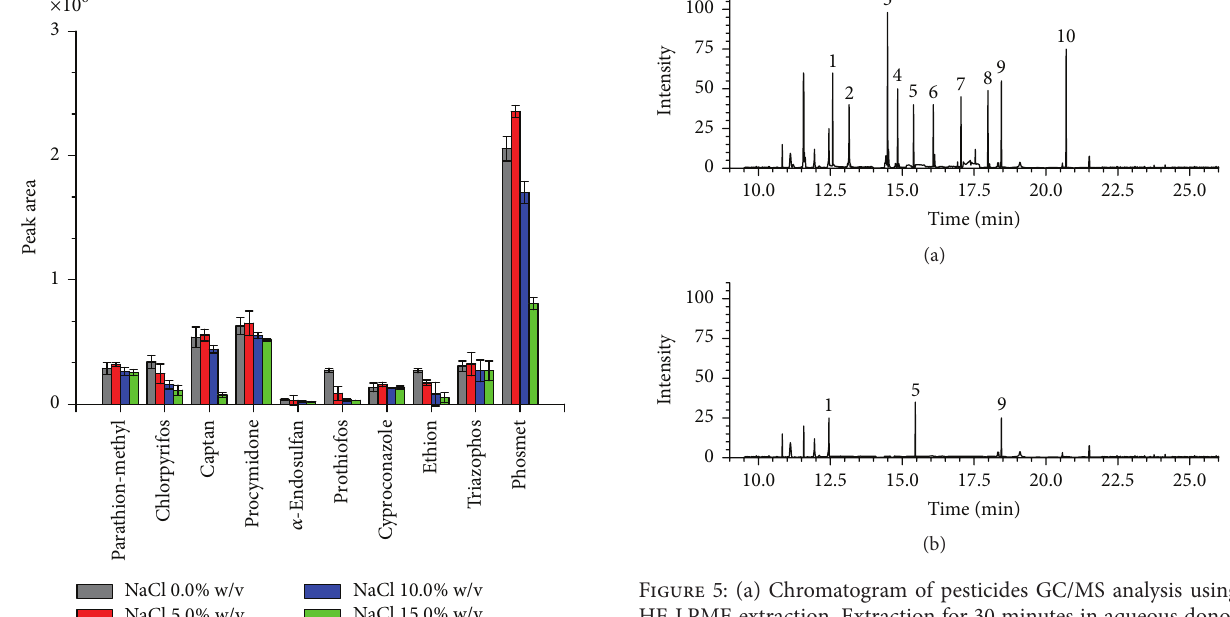
Figure 3: Influence of the aqueous phase ionic’s strength on pesticides extraction efficiency. Extraction conditions of the donor phase: 15.0 mL of water spiked at 100.0 𝜇 gL −1 of each pesticide with NaCl; extraction time of 60min; stirring speed of 100rpm; and ethyl octanoate in the acceptor phase. Error bars represented the standard deviation of the mean peak area for 𝑛 = 3 replicates.